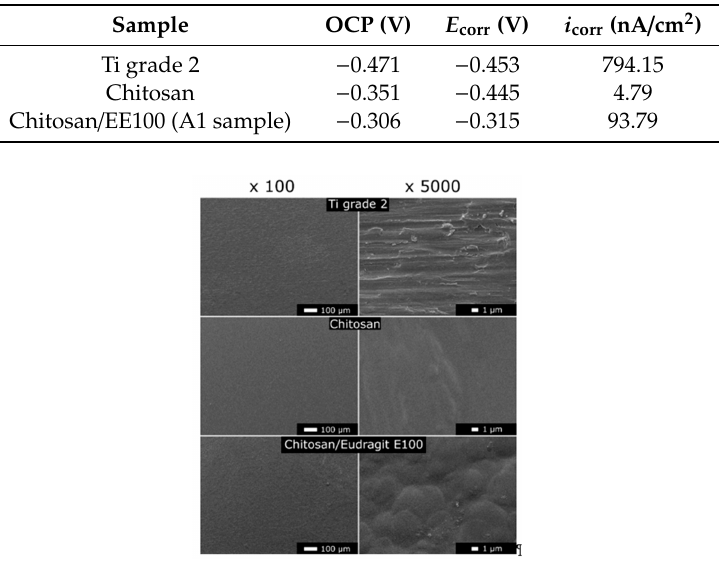
Figure 9. SEM images of the surface topography of the Ti grade 2 substrate, the chitosan coating, and the chit/EE100 coating obtained after corrosion studies; the images obtained at different magnifications, ×100 (on the left) and ×5000 (on the